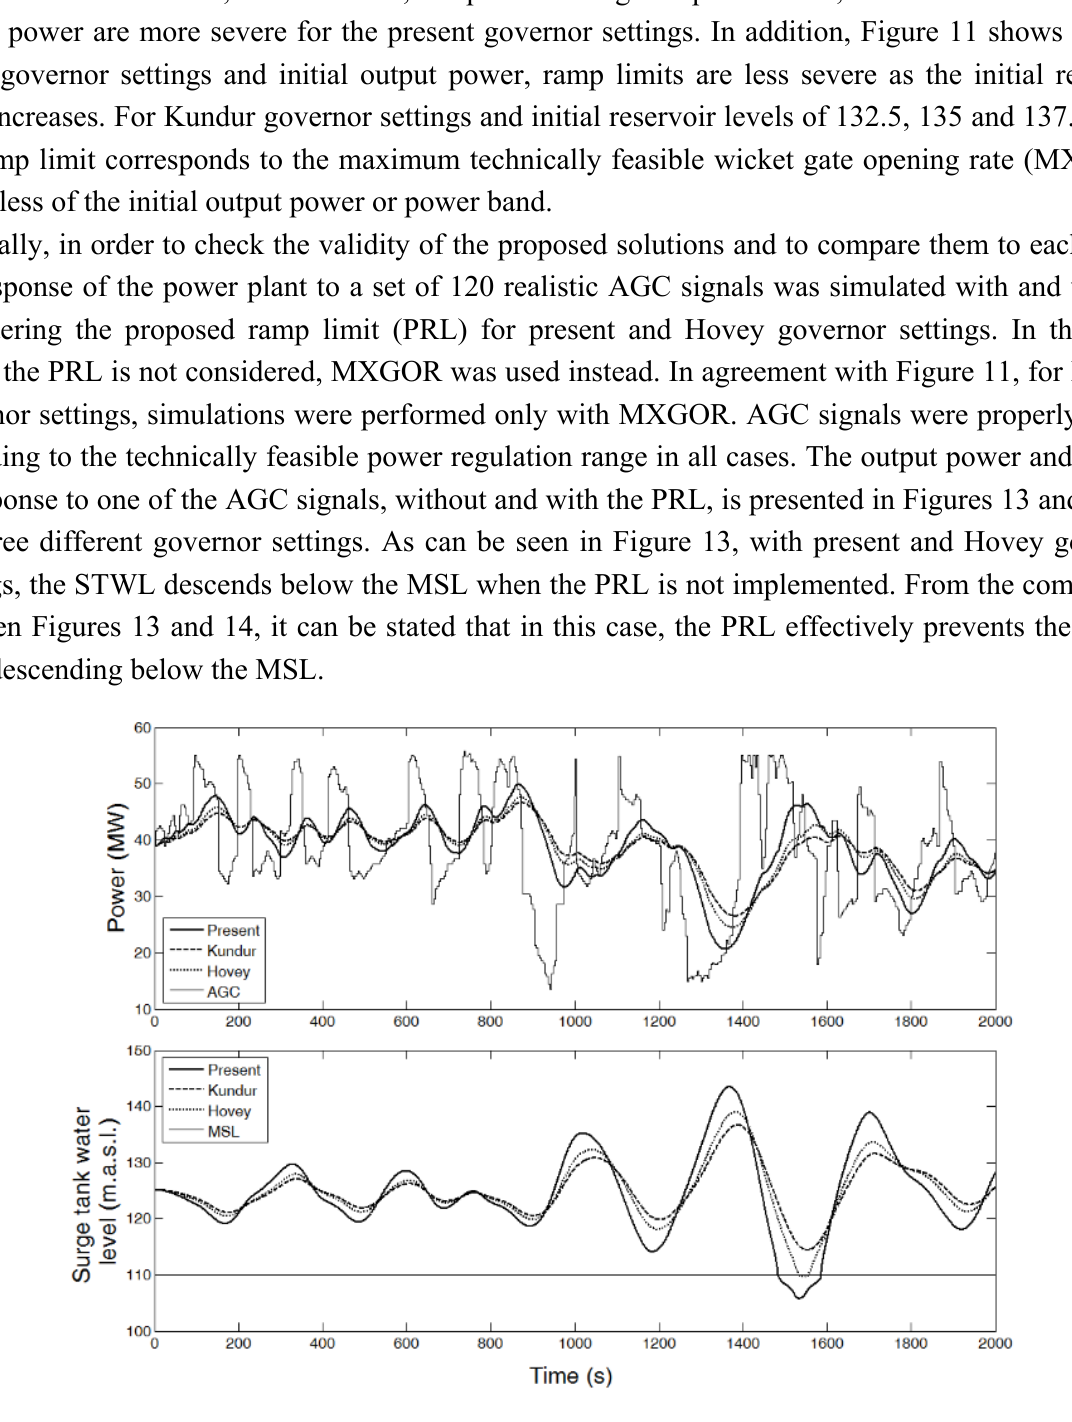
Figure 13. Output power and surge tank water level in response to an AGC signal for different governor settings (Present, Hovey, Kundur), with the maximum technically feasible wicket gate opening rate (MXGOR). AGC: automatic generation